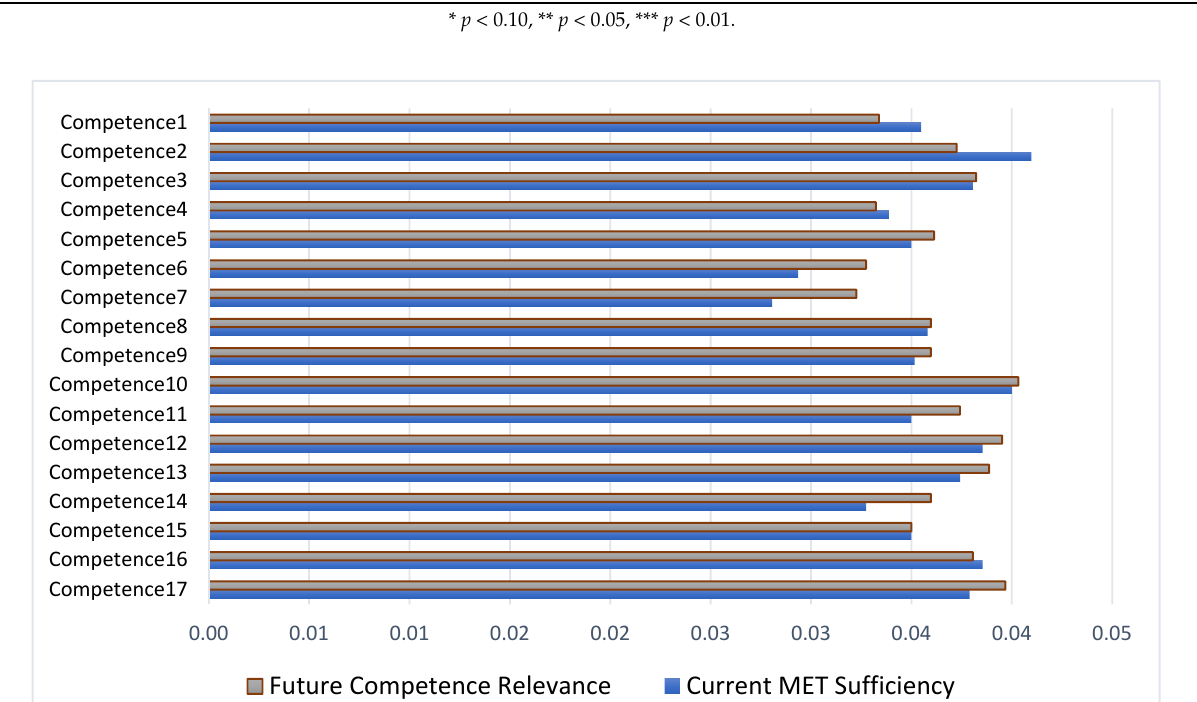
Figure 1. Radar plotted values for “current MET sufficiency” and “future competence relevance”. Further, a paired sample t -test ( p < 0.10) between the two means indicate that there is a statistically significant difference between the mean scores of “current MET sufficiency” and “future relevance” for the competences 2, 6, 7, 11, and 14, all of which has negative mean difference except for competence 2 (see Table 3). Table 3. Comparison of mean scores of statements related to STCW competence.